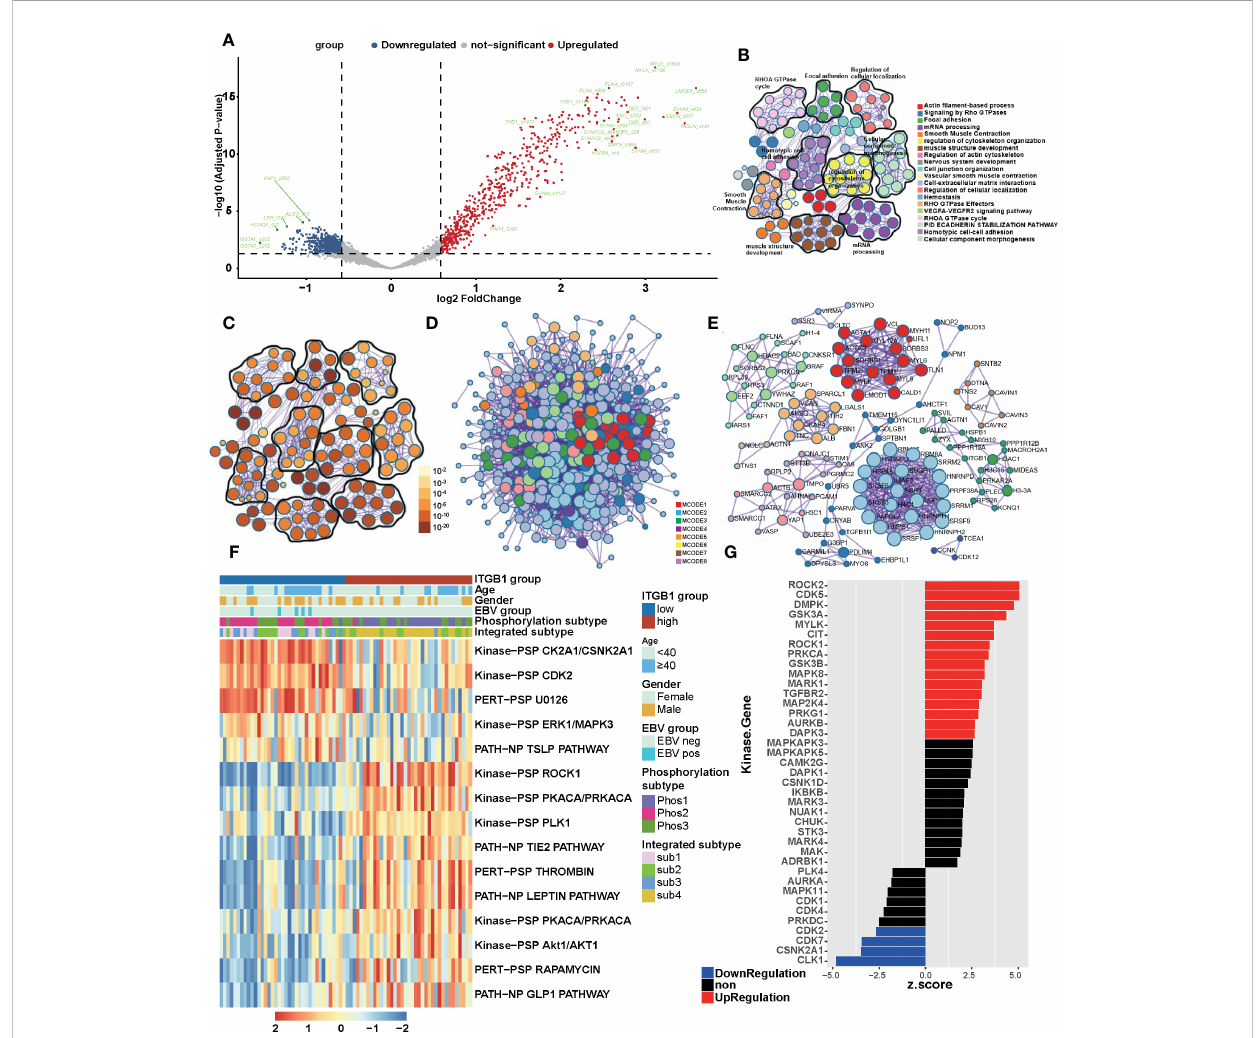
FIGURE 4 The landscape of biological processes of ITGB1 in DGC by the joint analysis of CPTAC and PKU in the phosphorylation level (A) Phosphorylation site regulated by ITGB1 in CPTAC database. Metascape enrichment network visualization summarized different biological processes (B) and relevance (C) in the phosphorylation level. The name of biological processes were showed in the right of chart. (D) Divided the set of proteins that physically interacted into 10 sub-clusters based on the MCODE method and proteins with the same clusters were characterized by the same GO terms and KEGG pathways. (E) The landscaoe of protein-protein interacting between and within the MCODE clusters. (F) The phosphorylation pathways in different ITGB1 groups were evaluated by the single sample GSEA (ssGSEA). (G) Kinase-Substrate Enrichment Analysis (KSEA) revealed the kinases associated with